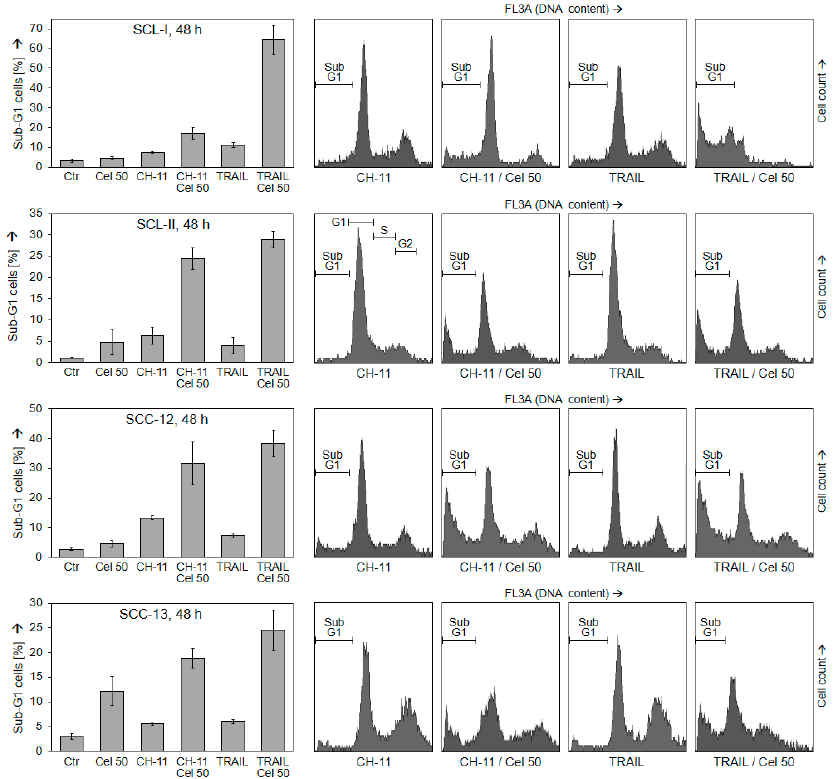
Figure 2. Induction of apoptosis in combinations with death ligands. Cell lines SCL-I, SCL-II, SCC-12 and SCC-13 were treated with celecoxib (50 µM), CH-11 (100 ng/mL), TRAIL (50 ng/mL) or combinations. Apoptosis was determined at 48 h by propidium iodide staining and cell cycle analysis. Left, results of representative experiments are shown. At least two independent experiments, each one with triplicate values, revealed highly comparable results. Right side, examples of flow cytometry measurements are shown (CH-11, TRAIL and combination treatments); apoptotic cell populations (sub-G1) are indicated.